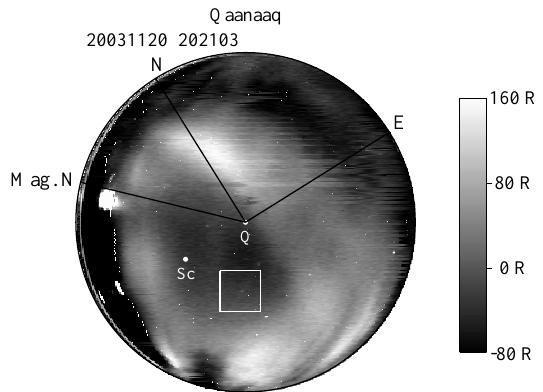
Figure 2. 630.0nm airglow image from Qaanaaq, Greenland, ob- served at 20:21UT on 20 November 2003. The white dots corre- spond to the zenith direction (Q) and the sub-ionospheric intersec- tion point of the scintillation system (Sc). The white square dis- played in the lower part of the image indicates the extension of a 32 × 32 pixel array used in the correlation